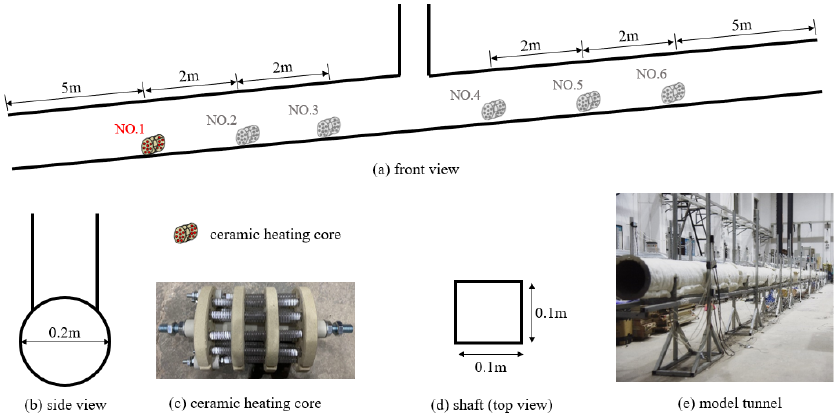
Figure 1. Schematic of tunnel model.